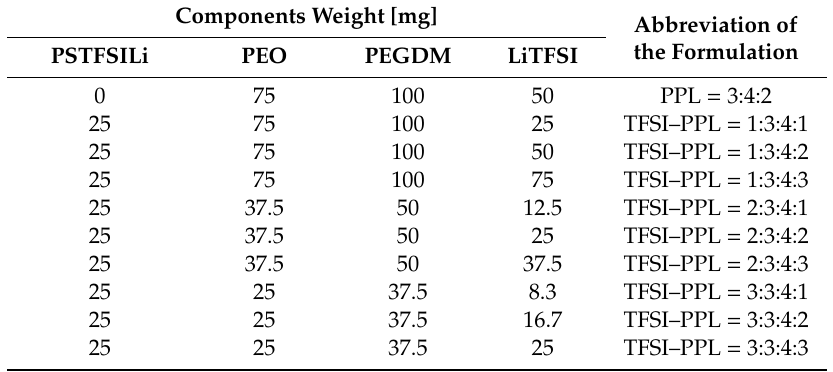
Table 3. Formulations of the SPE films with various weight ratios of PSPhSILi and LiTFSI. Components Weight [mg] Abbreviation of